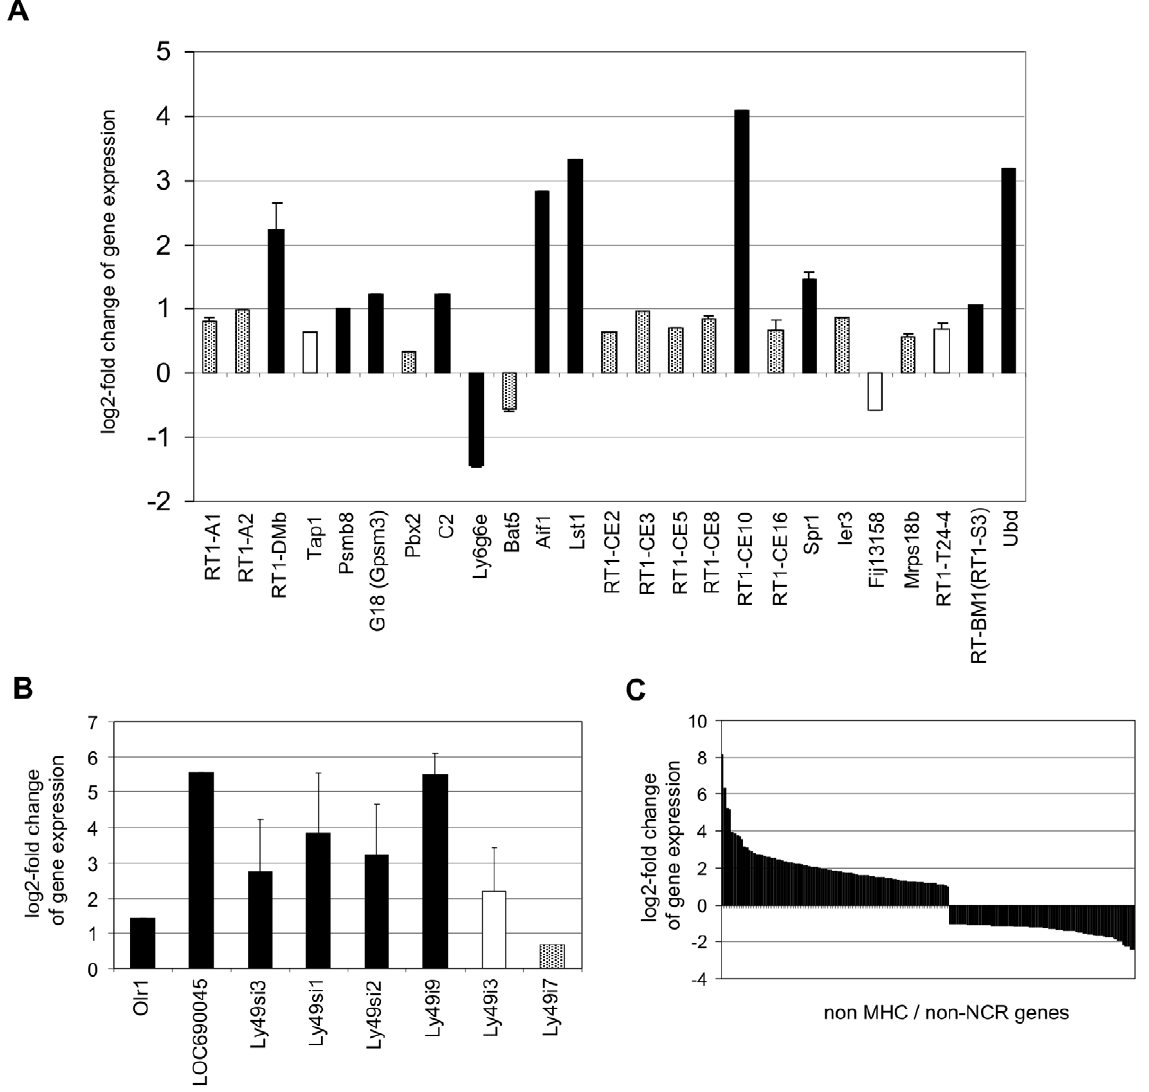
Figure 2. Expression profiling of BN skin explant samples exposed to allogeneic (PVG) lymphocytes in comparison to those exposed to syngeneic (BN) lymphocytes. ( A ) The log2-fold changes in gene expression of significantly regulated MHC genes (p , 0.05) are shown. ( B ) The log2-fold changes in gene expression of significantly regulated NKC genes (p , 0.05) are shown. ( C ) The log2-fold changes in gene expression of 168 significantly (p , 0.05) and strongly (log2-fold change $ 1 or #2 1) regulated non-MHC and non-NKC genes indicate the range of observed alterations in gene expression levels among the 6342 tested genes. In panels A and B , black bars indicate a strong change (log2-fold change $ 1 or #2 1), dotted bars alterations below this amplitude, and white bars expression changes that were not detected at a significant level with all, but at least with 50% of the probes present on the array for that gene. When more than one probe indicated a significant change of gene expression the means and standard deviations of the log2-fold changes are shown (see Tables S1, S2, and S3 for further